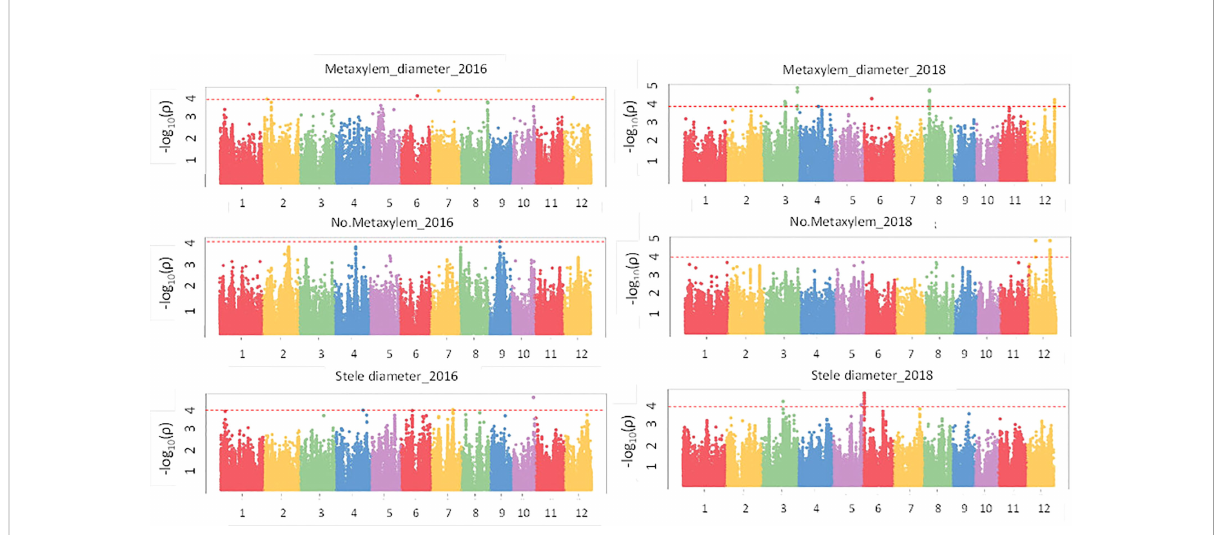
FIGURE 6 GWAS results for root anatomical phenotypes in puddled, transplanted (2016WS; left) and direct seeded (2018WS; right) trials on the Thai/SE Asia panel. WS, wet